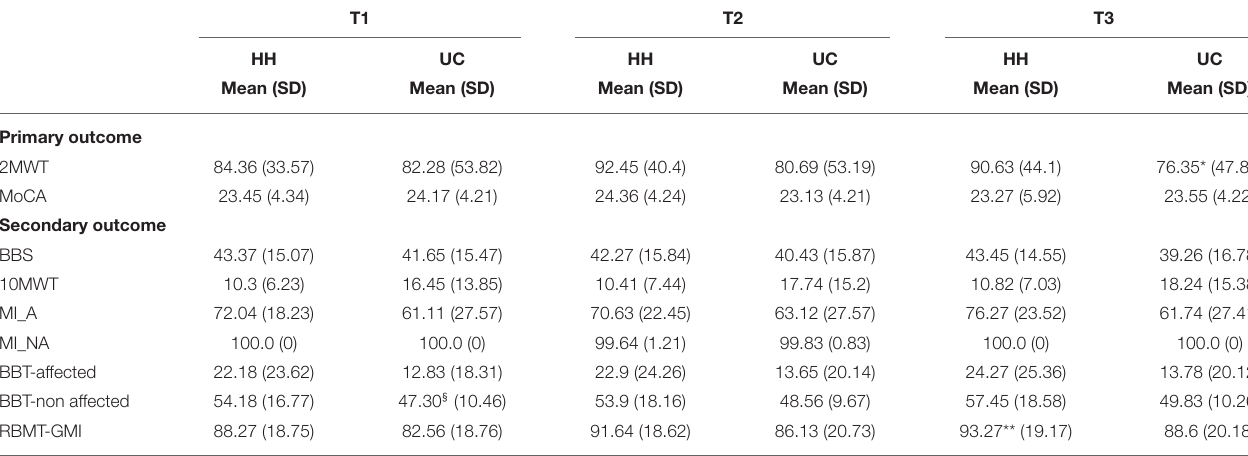
TABLE 3 | Means and SD of the HomeHEAD outcomes (T1, T2, and T3). T1 T2